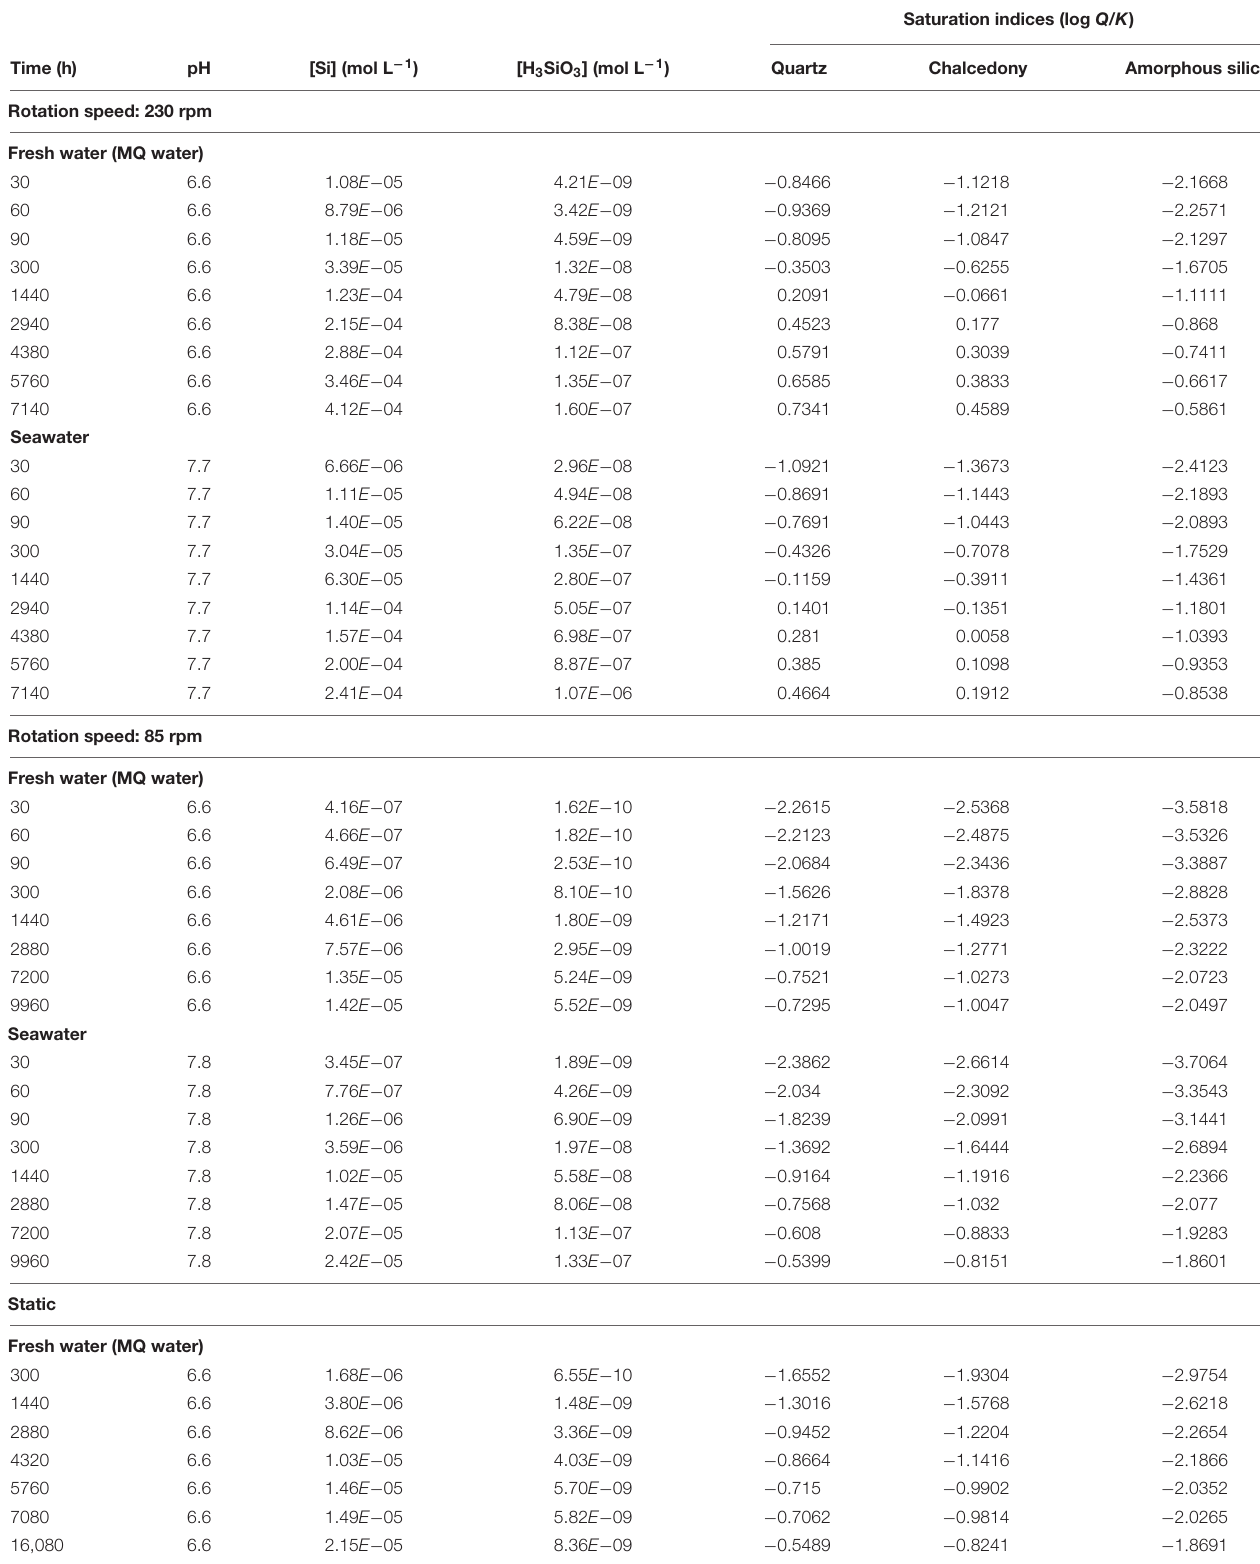
TABLE 3 | Calculated saturation indices (SIs) for silica mineral phases amorphous silica, chalcedony, and quartz.